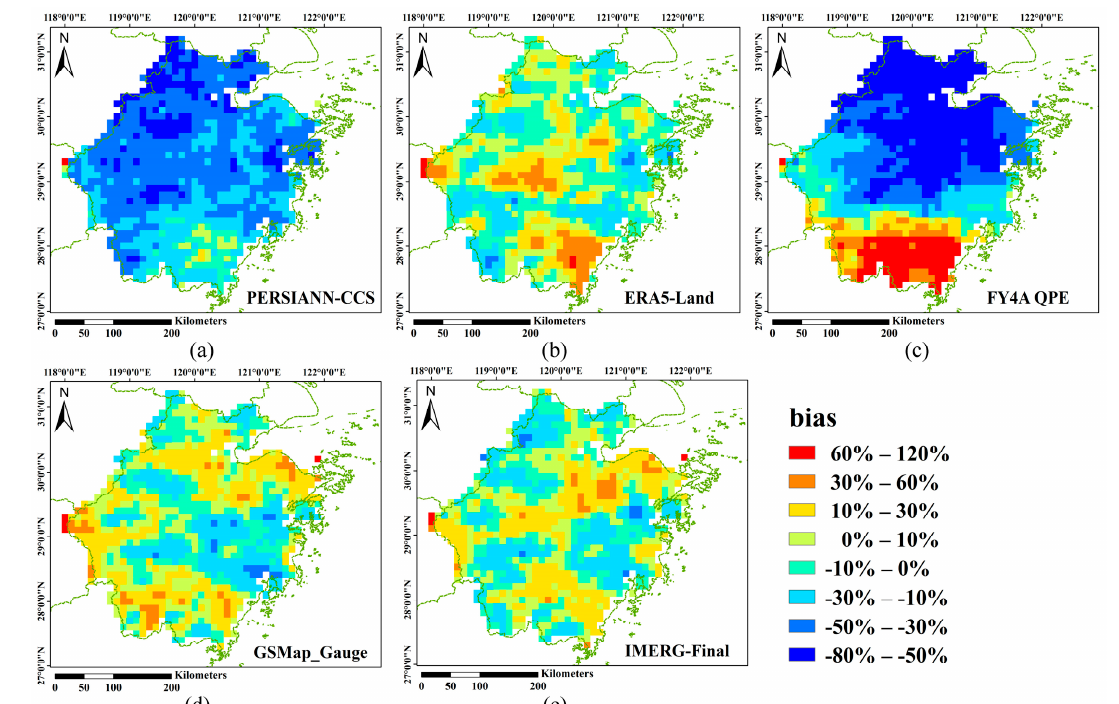
Water 2021 , 13 , x FOR PEER REVIEW Figure 4. Spatial patterns of bias based on ( a ) PERSIANN-CCS ( b ) ERA5-Land, ( c ) FY4A QPE ( d ) GSMap_Gauge, and ( e ) IMERG-Final against CMPA, at an hourly scale over the Zhejiang province in summer, from June to August 2019.